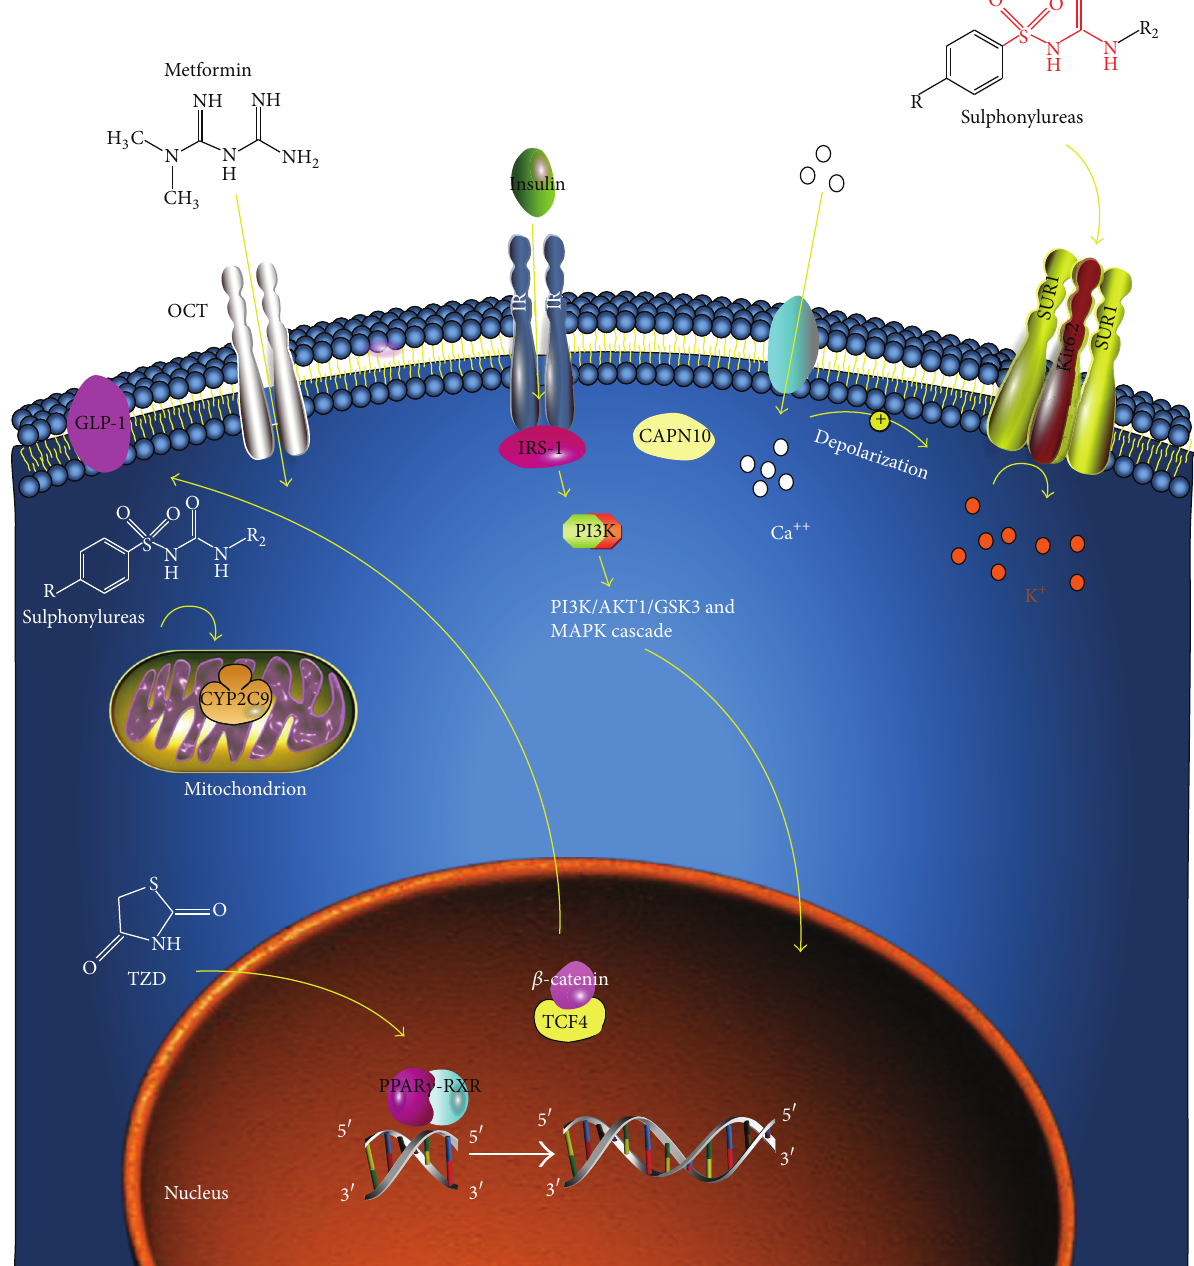
Figure 2: Main proteins involved in uptake and metabolism of OADs. IR = insulin receptor; GLP-1 = glucagon-like peptide-1; SUR1 = sulphonylureas receptor 1; Kir6.2 = potassium inward rectifier 6.2 subunit; PI3K = phosphoinositide 3-kinase; TCF4 = transcription factor 4; RXR = retinoid X receptor; PI3K/AKT1/GSK3 = phosphoinositide 3-kinase/RAC-alpha serine/threonine-protein kinase/glycogen synthase kinase 3; MAPK = mitogen-activated protein